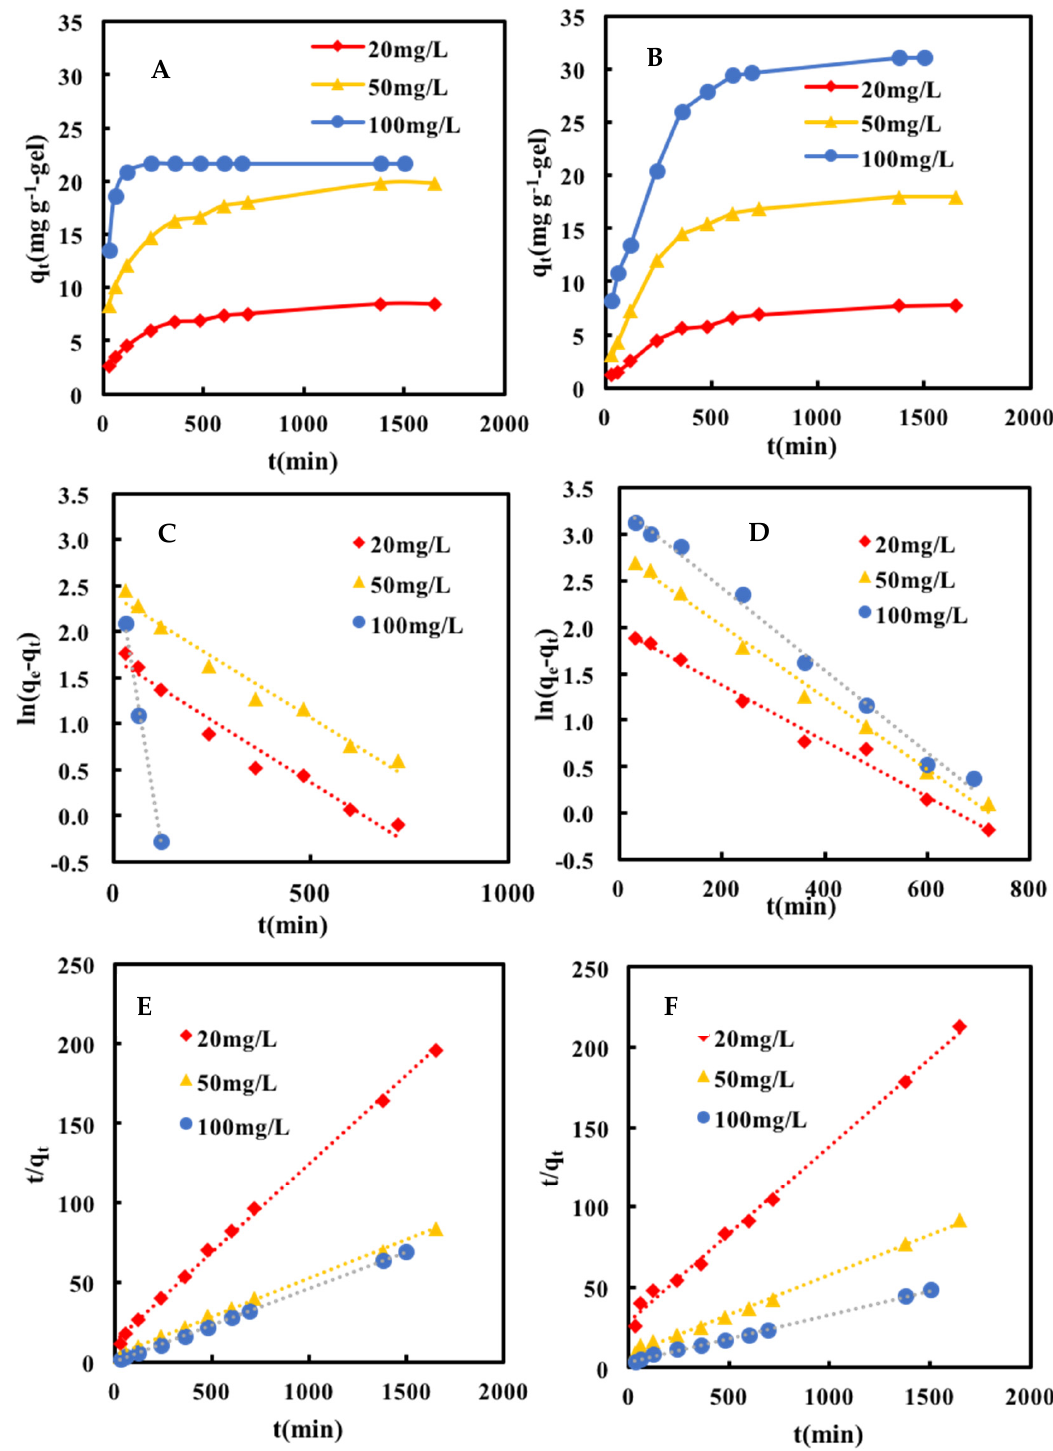
Figure 5. Adsorption kinetics of ( A ) D-Mn and ( B ) D-Cr gels; plots of the pseudo-first-order dynamic model of ( C ) D-Mn and ( D ) D-Cr gels; plots of the pseudo-second-order dynamic model of ( E ) D-Mn and ( F ) D-Cr gels.